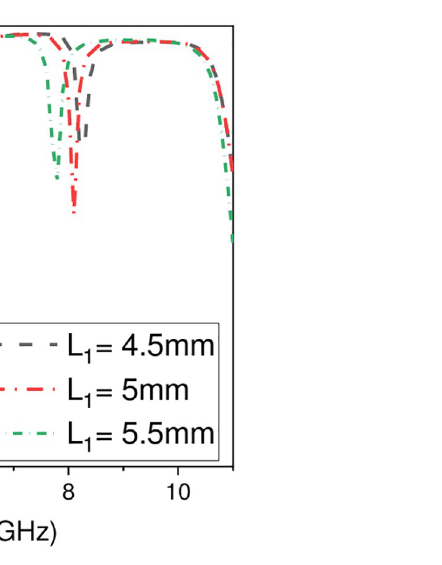
Fig 8. Experimental frequency plot of stopbands by varying L 1 .